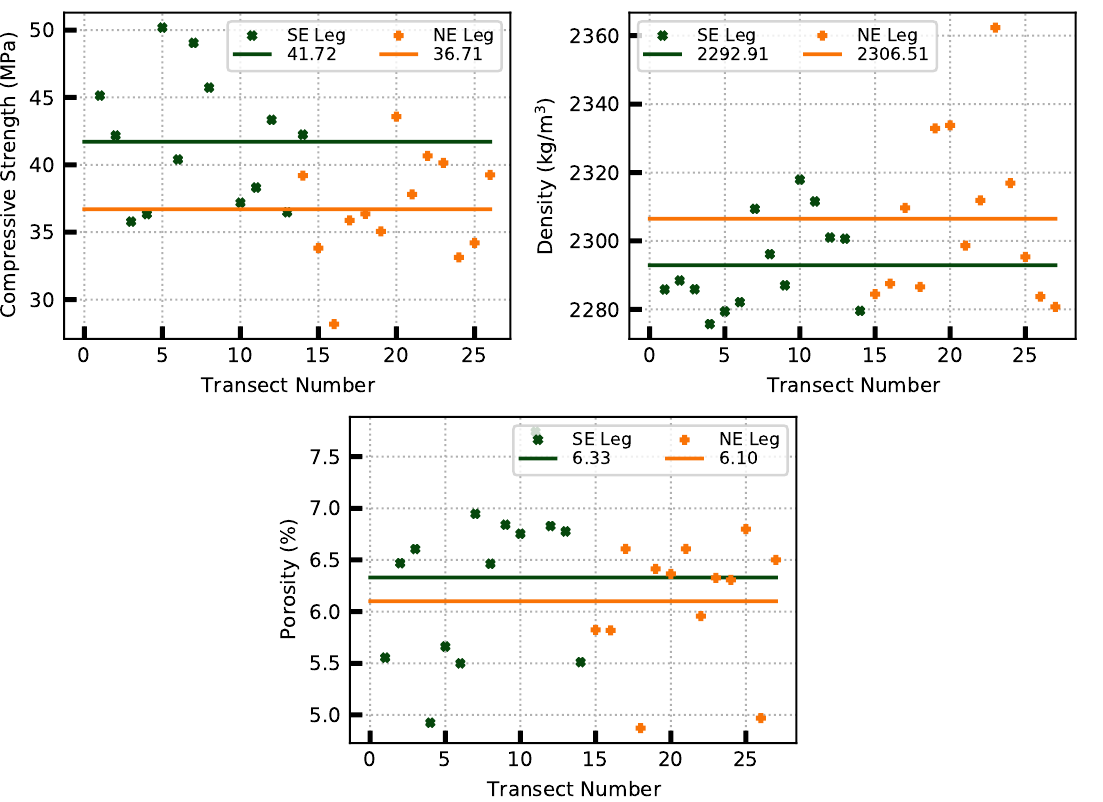
Figure 14. Spatial differences in material properties between the southeast and northeast